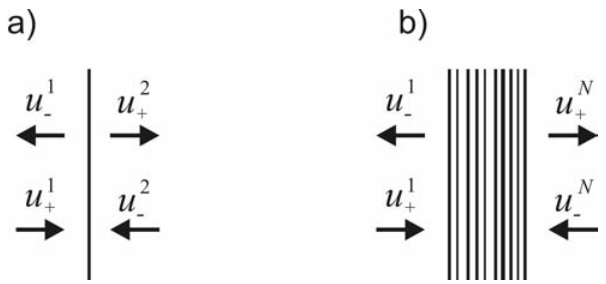
Figure 6. One-dimensional scattering problem. a) On a single boundary. b) On a random sequence of